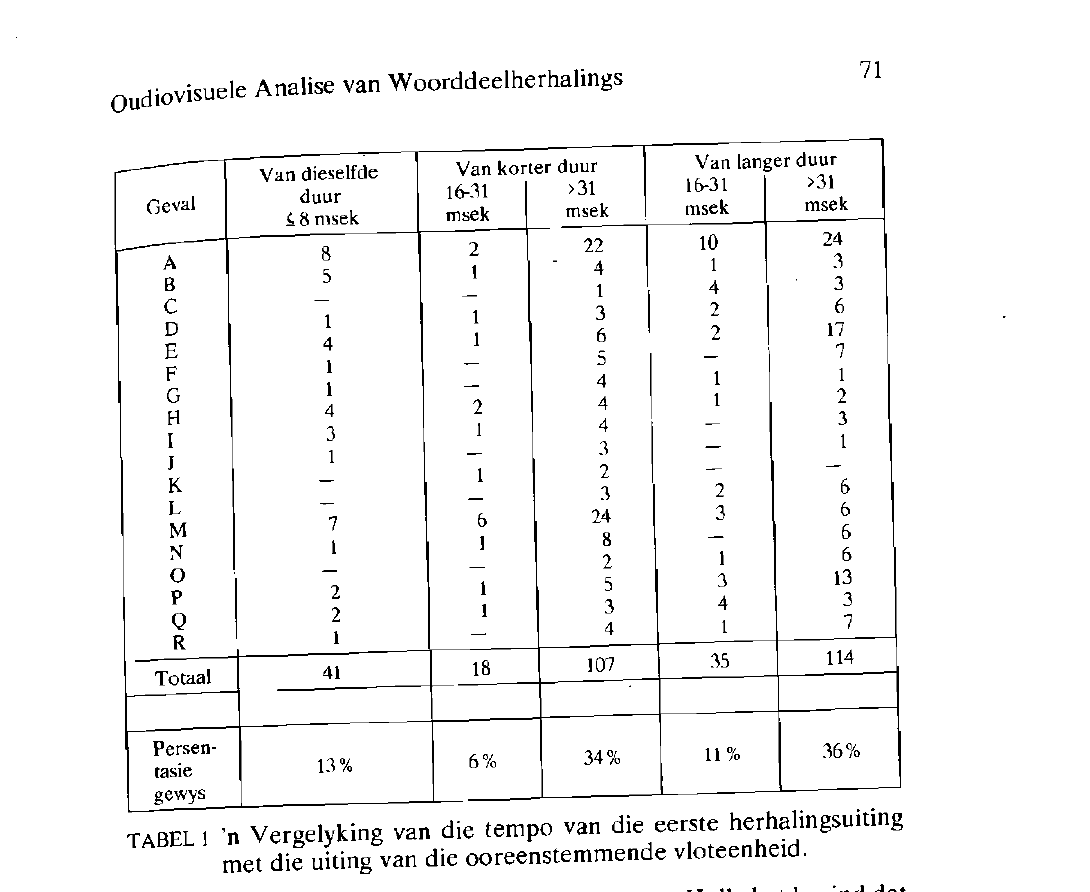
TABEL ι 'n Vergelyking van die tempo van die eerste herhalingsuiting met die uiting van die ooreenstemmende